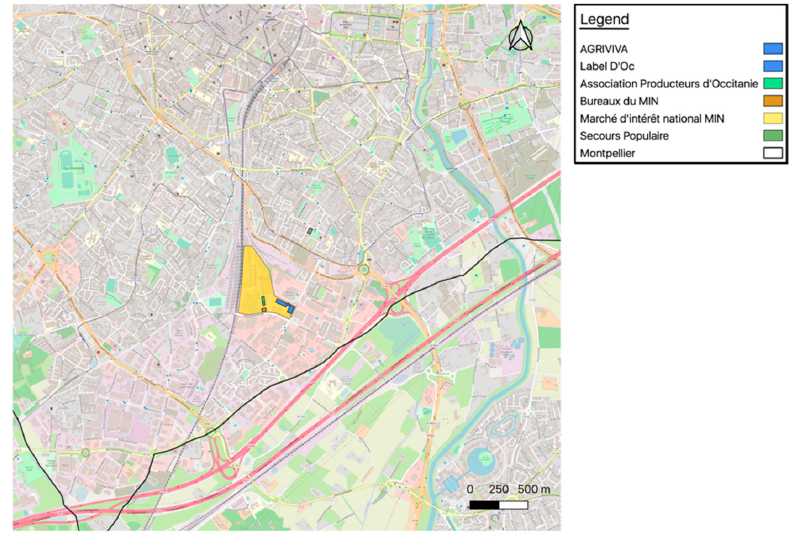
Figure 7. The cluster in the Restanque neighborhood of the